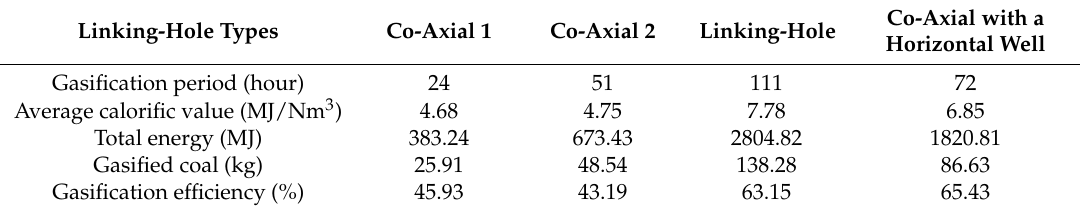
Table 2. Calculation results of gasification